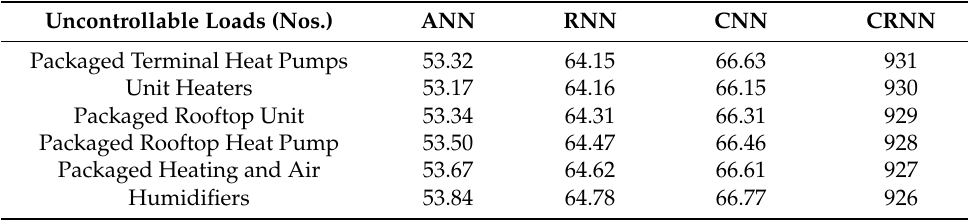
Table 2. Transmission rate (MBPS) with more smart buildings.